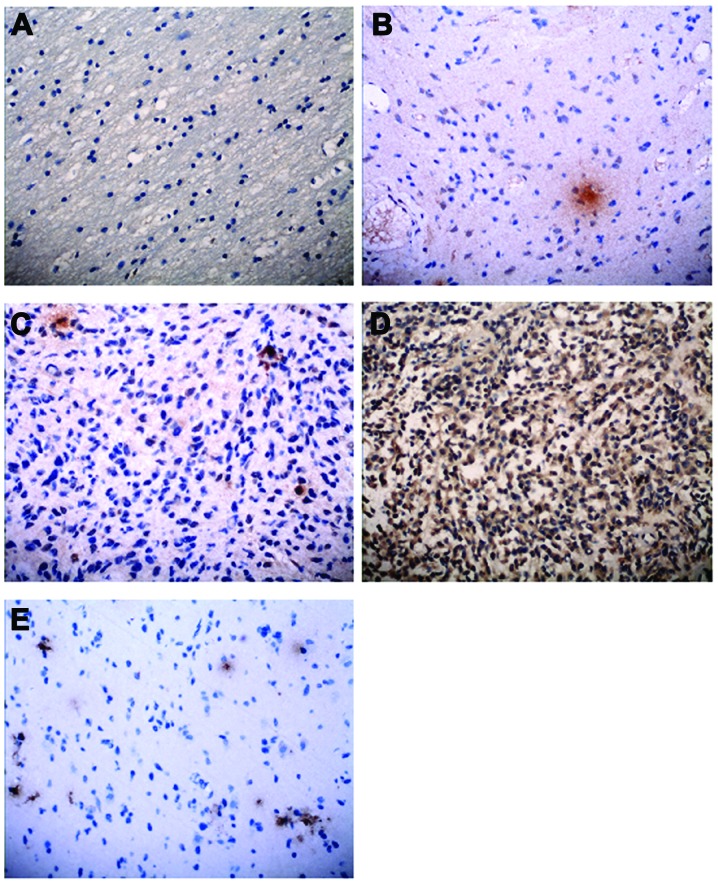
Immunohistochemical analysis of β1,3-N-acetylglucosaminyltransferase-8 (β3GnT8) in glioma tissues and normal brain tissues. The figures showed the strongly cytoplasmic staining of β3GnT8 in glioma tissues. (A) Normal brain tissue; (B) WHO grade II; (C) WHO grade III; (D) WHO grade IV; (E) negative control (magnification, ×200).